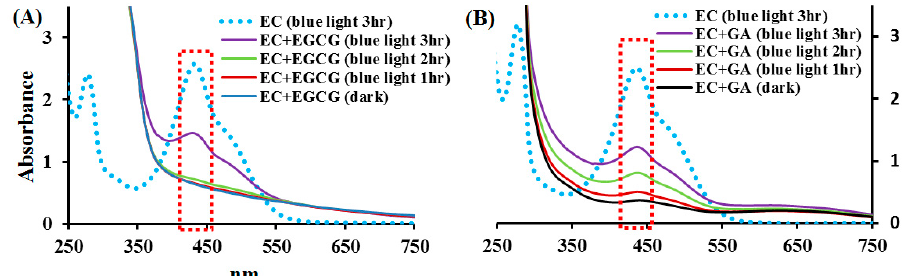
Figure 5. The absorption spectra of ( A ) ECPB at pH 8.0 treated with EGCG with illumination by blue light at 2.0 mW/cm 2 for 1, 2, and 3 h; and ( B ) ECPB treated with GA and illuminated by blue light at 2.0 mW/cm 2 for 1, 2, and 3 h. The absorbance of the reaction solutions was measured within the spectral range from 250 to 750